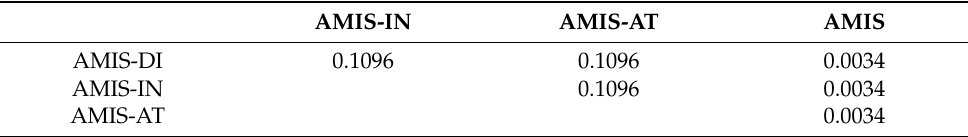
Table 21. Statistical testing using the Wilcoxon signed-rank test of the results in Table 20.